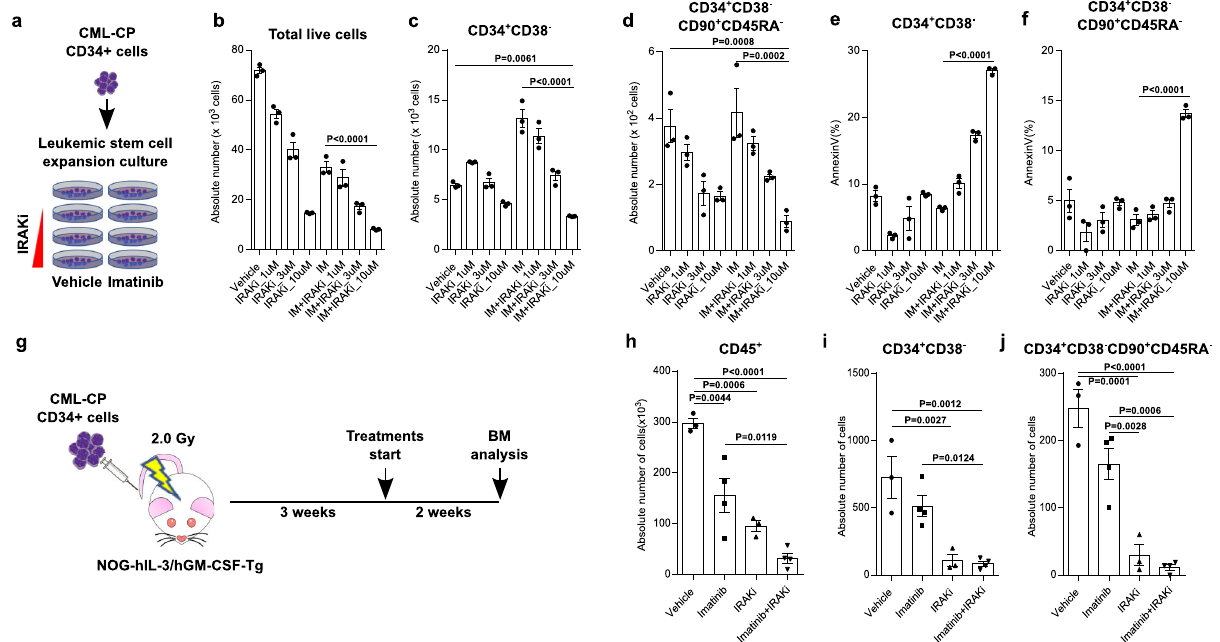
Fig. 4 IRAK1/4 inhibitor together with imatinib is detrimental to human CML LSCs. a – f CD34 + cells (1×10 3 ) from the BM of a newly diagnosed CML-CP patient were cultured in liquid culture in the presence of imatinib (IM: 0.5 µ M) or IRAK1/4 inhibitor (IRAKi (R568): 1, 3 or 10 µ M) alone or in combination for one week ( n = 3 each) ( a ). Similar results from two different patients are shown in Fig. S3. Absolute number of total live cells ( b ), CD34 + CD38 − cells ( c ) and CD34 + CD38 − CD90 + CD45RA − cells ( d ). Percentage of apoptotic cells in CD34 + CD38 − cells ( e ) and CD34 + CD38 − CD90 + CD45RA − cells ( f ) was measured by annexin staining. g – j NOG-hIL-3/hGM-CSF mice were transplanted with CD34 + cells from the BM of a CML-CP patient ( n = 1) and treated with vehicle ( n = 3), imatinib ( n = 4), IRAK1/4 inhibitor (IRAKi (R930259 Diet): 100 ppm) ( n = 3), or the combination of these ( n = 4). g Experimental design. Absolute number of human CD45 + cells ( h ), CD34 + CD38 − cells ( i ), and CD34 + CD38 − CD90 + CD45RA − cells ( j ) in the BM were analyzed at the end of the experiment. Data are shown as the mean ± SEM. P values are calculated using one-way ANOVA with Tukey ’ s correction for multiple comparisons ( b – f , h – j